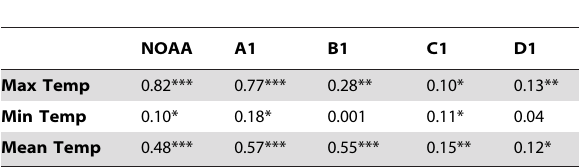
Table 3. The relationship between PRISM’s interpolated yearly temperature values and those of the RMFR transect weather stations over the last